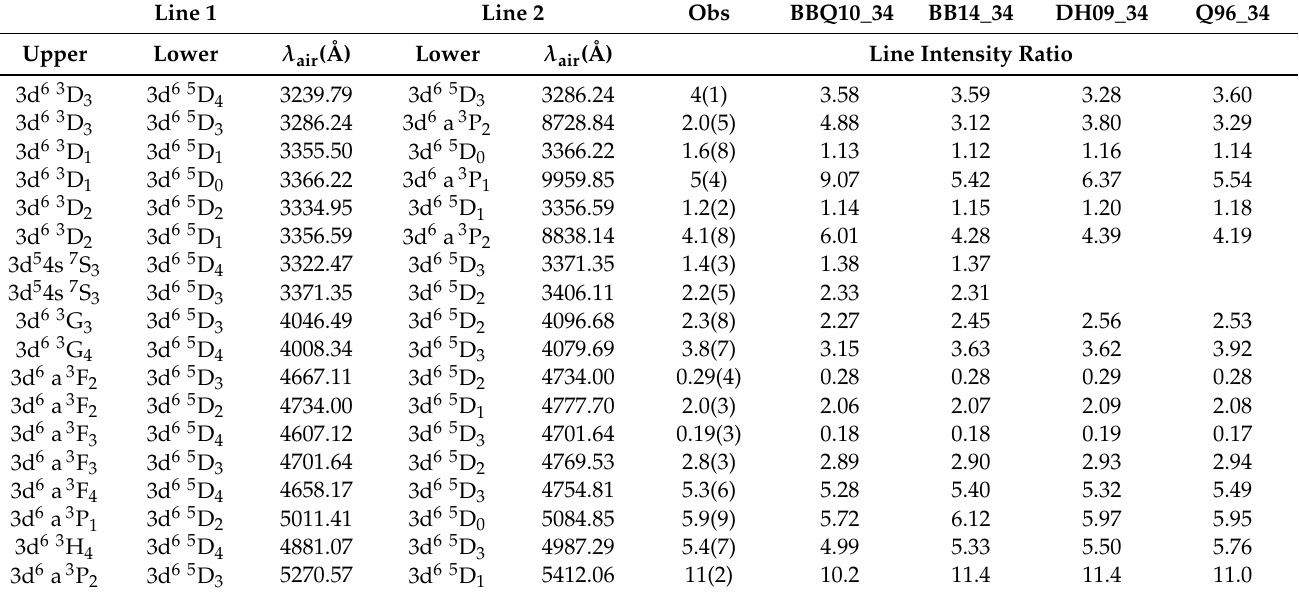
Table 2. Comparison of observed [Fe III ] line intensity ratios in HH202S (Obs) for transitions sharing a common upper level with those estimated from the A -values in the BBQ10_34, BB14_34, DH09_34, and Q96_34 atom files. The error of the least significant figure of the observed intensity ratio is indicated in brackets.